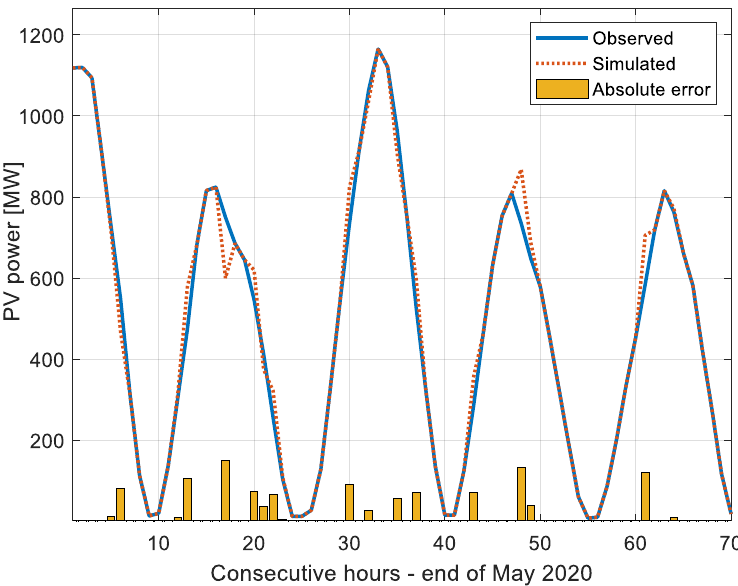
Figure 6. Performance of the neural network for the testing subset. Please note that night hours (no irradiation) are excluded.